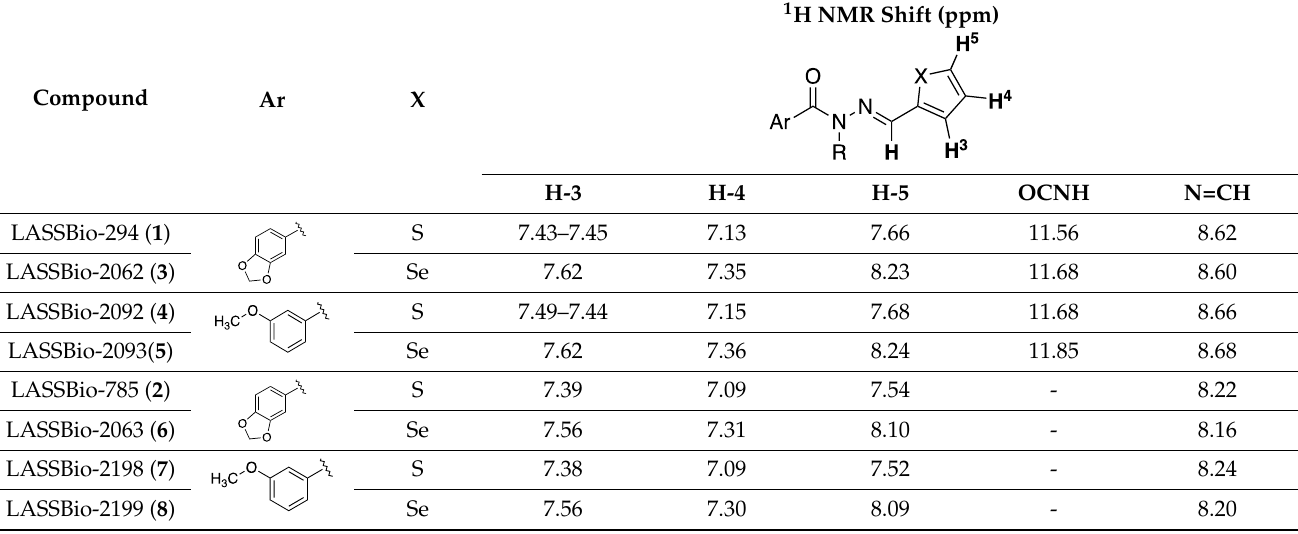
Table 1. 1 H-NMR (400 MHz, DMSO- d 6 , 25 ◦ C) shifts of compounds 1 – 8 . Comparison between the hydrogens H-3, H-4, H-5 of the heterocycles, iminic, and amidic hydrogens in NAH-derivatives 1 – 8 , demonstrating the deshielding in selenophene isosters.